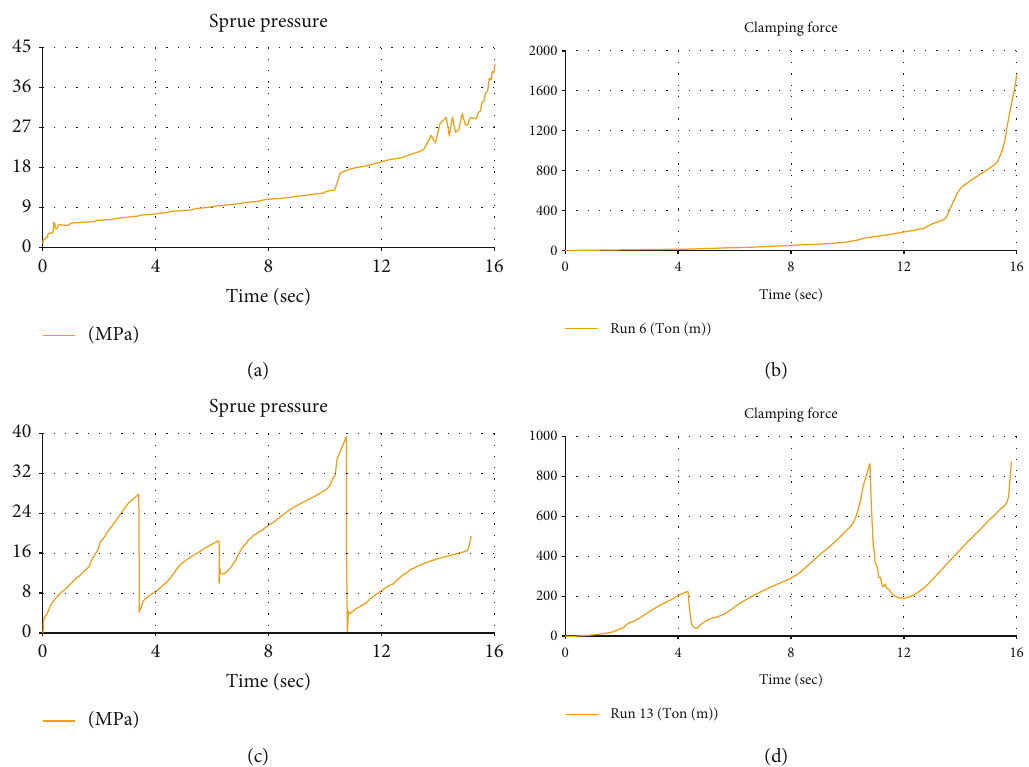
Figure 7: Filling pressure and clamping force history. (a) Filling pressure by concurrent valve gate opening scheme. (b) Clamping force by concurrent valve gate opening scheme. (c) Filling pressure by sequential valve gate opening scheme. (d) Clamping force by sequential valve gate opening